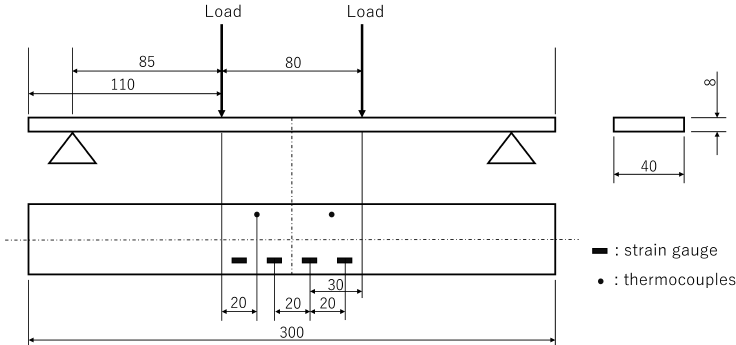
Figure 4. Geometry of the specimen used for the four-point bending test.